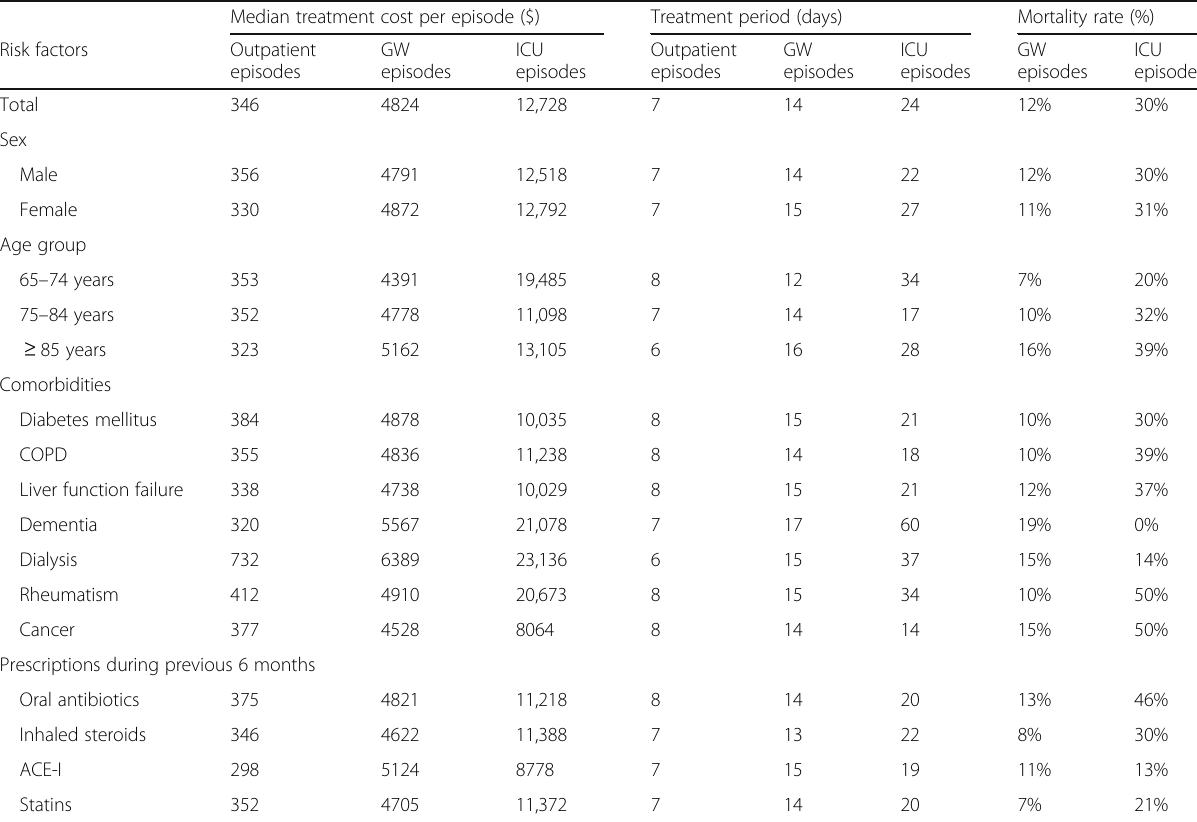
Table 4 The median treatment costs, treatment periods, and mortality rates according to risk factors Median treatment cost per episode